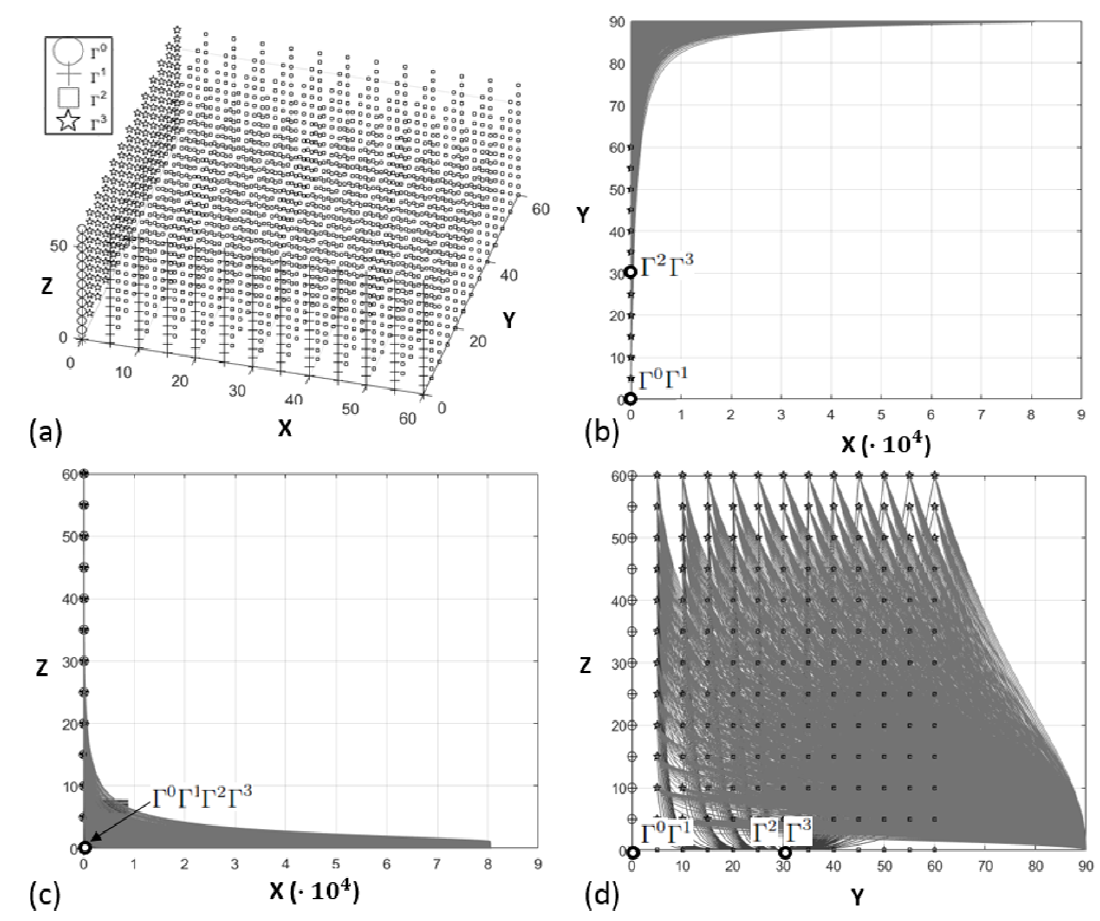
Figure 2. (a) Initial conditions x 0 , y 0 , z 0 , assuming h 0 = 0, used to compute the phase-portraits shown in figures a , b and c . Different symbols were used to identify the steady-state they lead to according to the legend (e.g. the initial conditions identified by the squares lead to Γ 2 steady-state). The plots b , c and d represent the phase-portraits of respectively x - y , z - x and z - x populations (note that the x -axis is not in scale with y and z axes). The parameters used are: r 1 = r 2 = 0.3, a = 5 · 10 − 6 , k = 5 · 10 − 4 , ν = 1, b = 0, p = 1, α 12 = α 21 = 0.6, d 2 = 0.01, (cid:101) 1 = (cid:101) 2 = 0.3; the discretization parameters are dt = 10 − 5 and q = 1.5. Each steady-state was labeled with a black-white